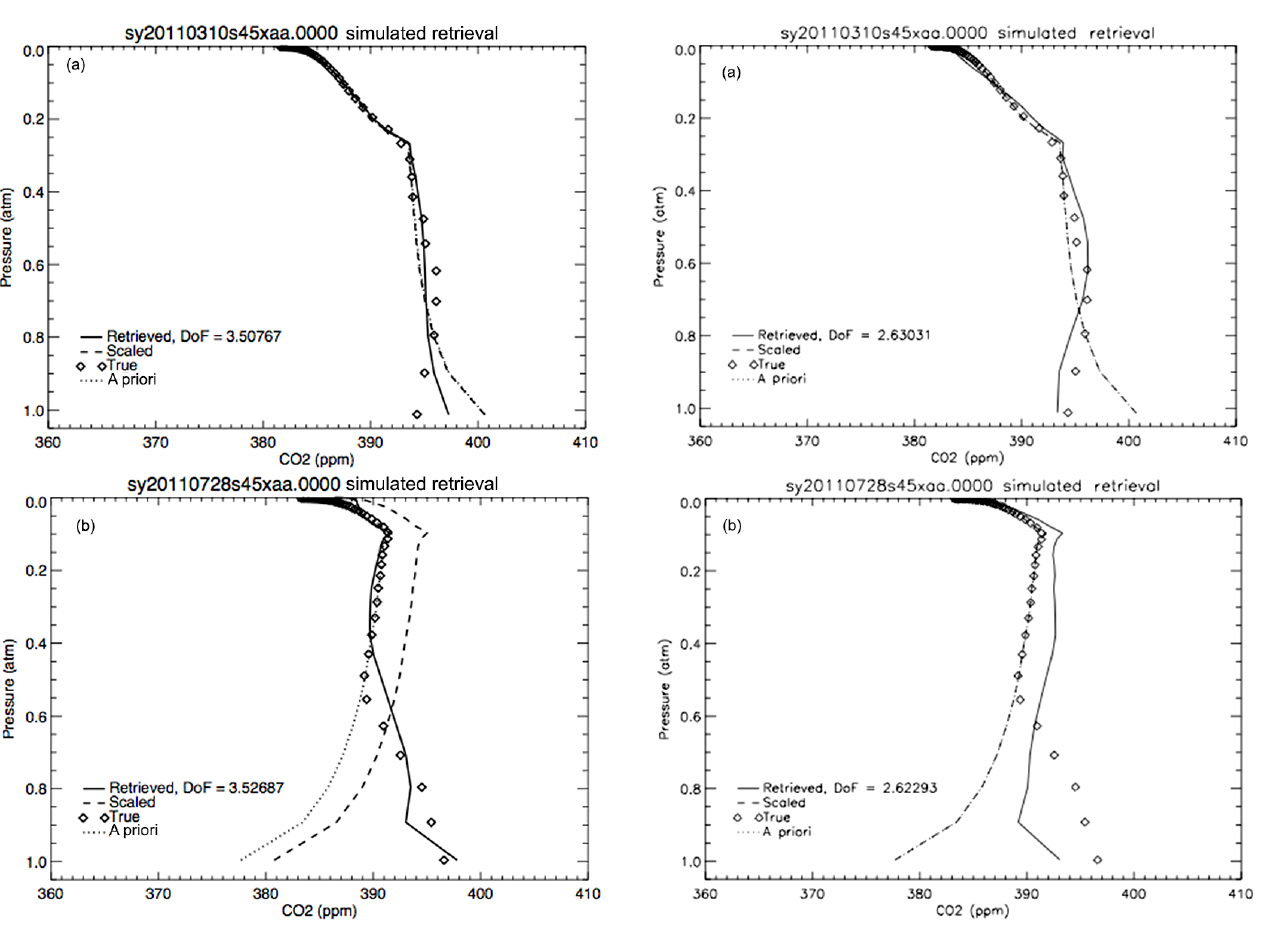
Figure 5. (a) As Fig. 4a, with telescope pointing error assumed. (b) As Fig. 4b but with telescope pointing error